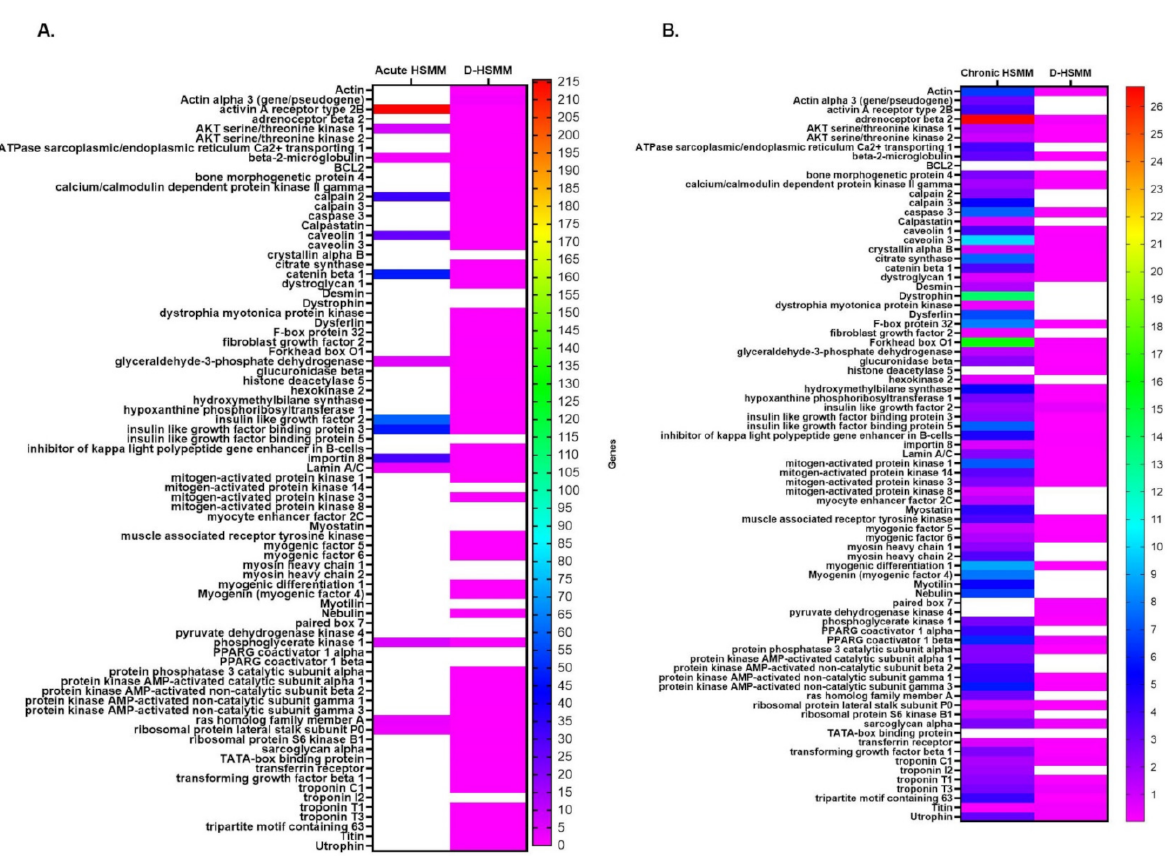
Figure 2. A heatmap of gene expression of the relative qualitative assessed gene in HSMM and D-HSMM following the ( A ) acute and ( B ) chronic heat treatments. All values are expressed in fold-change compared to the control, with eukaryotic 18S rRNA as the endogenous